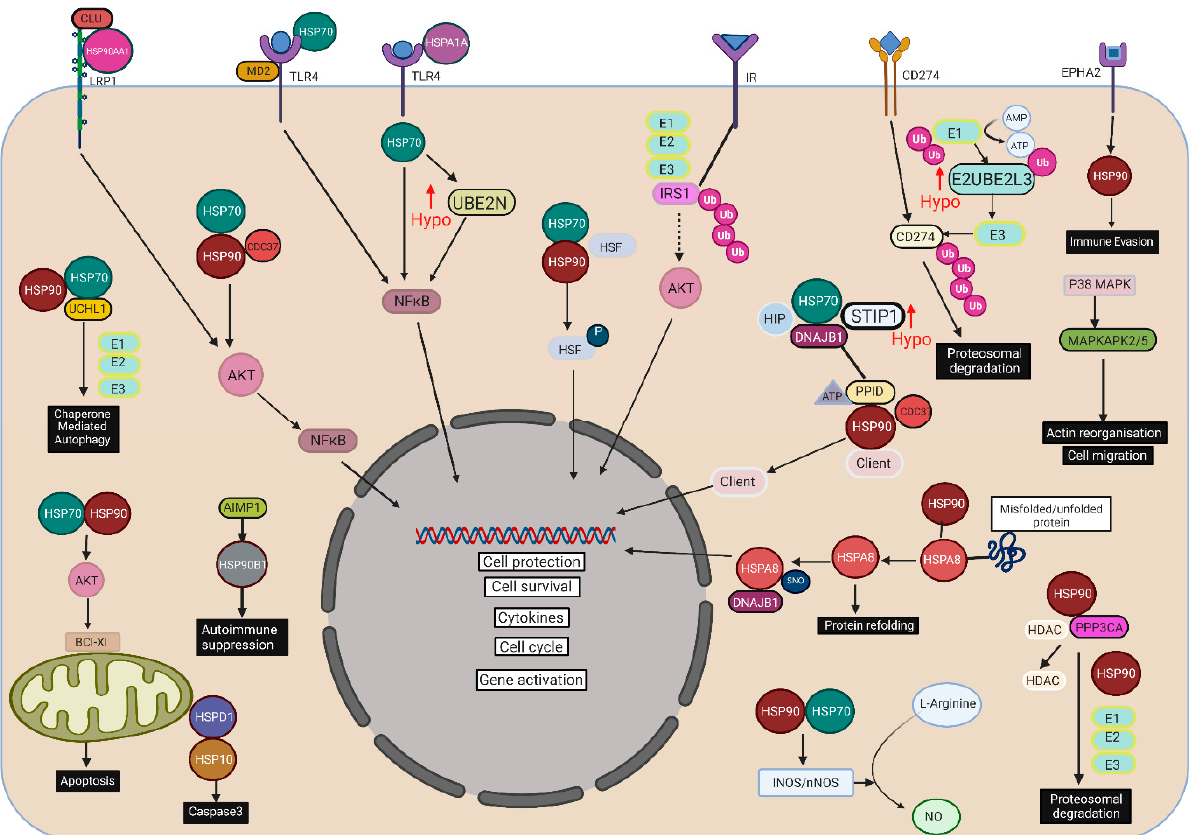
Figure 1. Schematic representing the recognized interactions between heat shock proteins (HSPs) and related proteins that, in response to severe acute hypoglycemia, are differentially expressed. Upward red arrows show proteins that, in T2D, were upregulated in response to hypoglycemia. HSP90 alpha (HSP90AA1, HSP90AB1, HSP90 beta, HSP90 dimer); HSPA1A, heat shock 70 kDa protein 1A; HSPA8, heat shock cognate 71 kDa protein; HSPD1, 60 kDa heat shock protein, mitochondrial; AIMP1, aminoacyl tRNA synthase complex-interacting multifunctional protein 1; CDC37, Hsp90 co-chaperone Cdc37; CLU, clusterin; DNAJB1, DnaJ homolog subfamily B member 1; MAPKAPK2, MAP kinase-activated protein kinase 2; MAPKAPK5, MAP kinase-activated protein kinase 5; PPID, peptidyl-prolyl cis-trans isomerase D; PPP3CA, serine/threonine-protein phosphatase 2B catalytic subunit alpha isoform; STIP1, stress-induced phosphoprotein 1; TLR4, toll-like receptor 4; TLR4:MD-2 complex, toll-like receptor 4 in complex with MD-2; CD274, programmed cell death 1 ligand 1; EPHA2, ephrin type-A receptor 2; E1, ubiquitin-activating enzyme; E2, ubiquitin-conjugating enzyme 2 (UBE2L3, ubiquitin-conjugating enzyme E2 L3; UBE2N, ubiquitin-conjugating enzyme E2 N); UCHL1, ubiquitin carboxyl- terminal hydrolase isozyme L1; E3, ubiquitin ligases; NF κ B, nuclear factor kappa-light-chain-enhancer of activated B cells; AKT, protein kinase B, HSF, heat shock factors; SNO, S-nitrosylation; P38 MAPK, p38 mitogen-activated protein kinases; Bcl-xL, B-cell lymphoma-extra large; LRP1, low-density lipoprotein receptor-related protein 1; IR, insulin receptor; IRS1, insulin receptor substrate